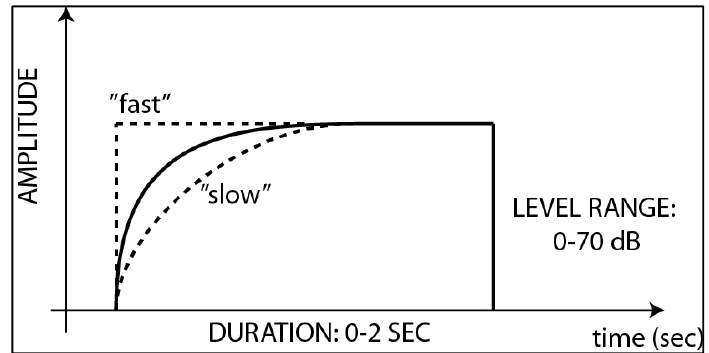
Figure 6. Time window envelope settings used for processing the short signals according to the selected parameters of the amplitude, duration and the amplitude growth rate.